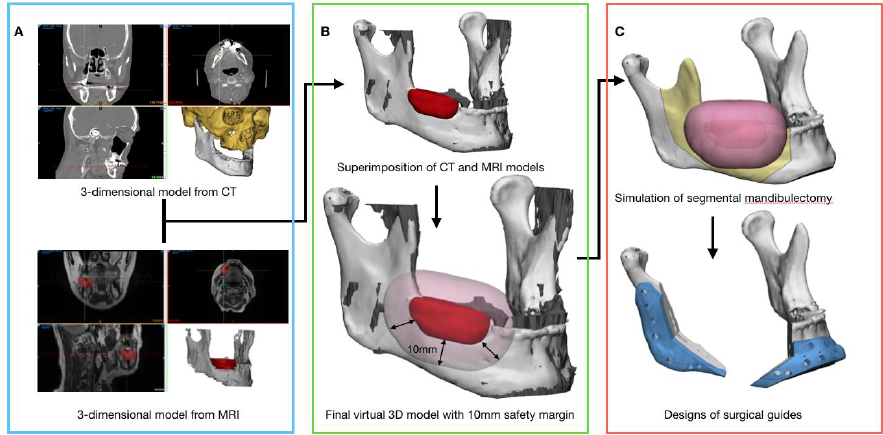
Figure 1. Digital workflow of preoperative surgical simulation and guide fabrication. ( A ) A three- dimensional cranio-maxilla and mandible model is generated from computed tomography (CT) and a three-dimensional mandible with a localized tumor from magnetic resonance imaging (MRI) is generated by the medical software; ( B ) by superimposing three-dimensional models of CT and MRI, tumor information obtained from MRI is shared with the high-resolution mandibular bone model from CT; ( C ) preoperative surgical simulation of the final virtual three-dimensional model and design of the surgical guides transferred from virtual reality to the operating room.